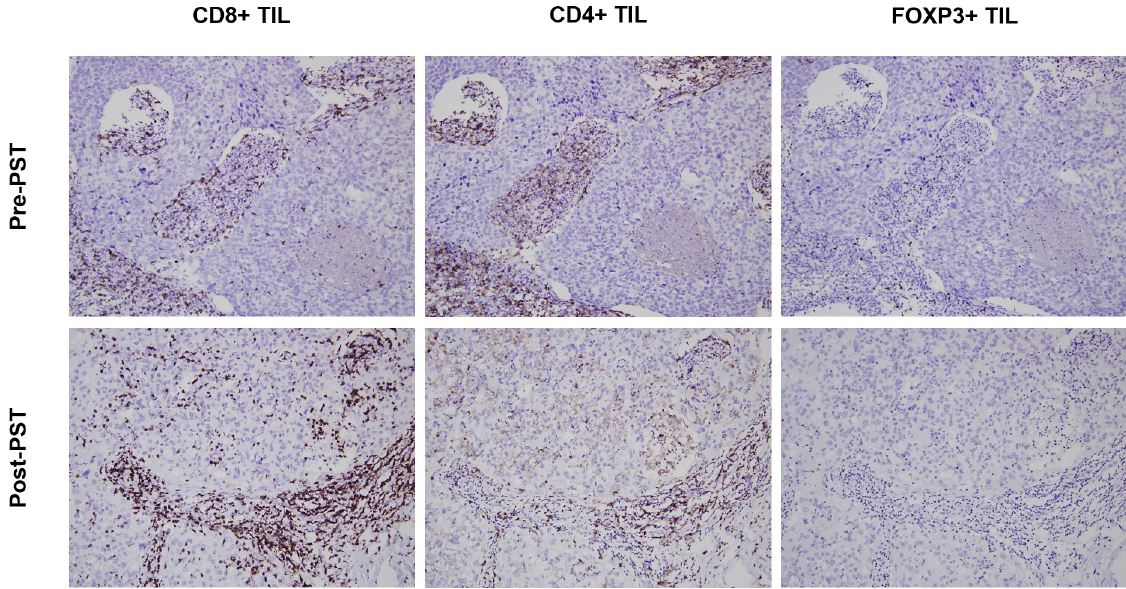
Fig 1. A representative chemo-responsive case showing changes in the infiltration of CD8+, CD4+, and FOXP3+ tumor-infiltrating lymphocytes after primary systemic therapy. CD8+ tumor-infiltrating lymphocytes (TILs) increased significantly after primary systemic therapy (PST), especially in the intratumoral compartment. CD4+ TILs increased slightly in the intratumoral compartment, but decreased in the stromal compartment after PST. FOXP3+ TILs decreased significantly with no identifiable cells in the figure (Original magnification,